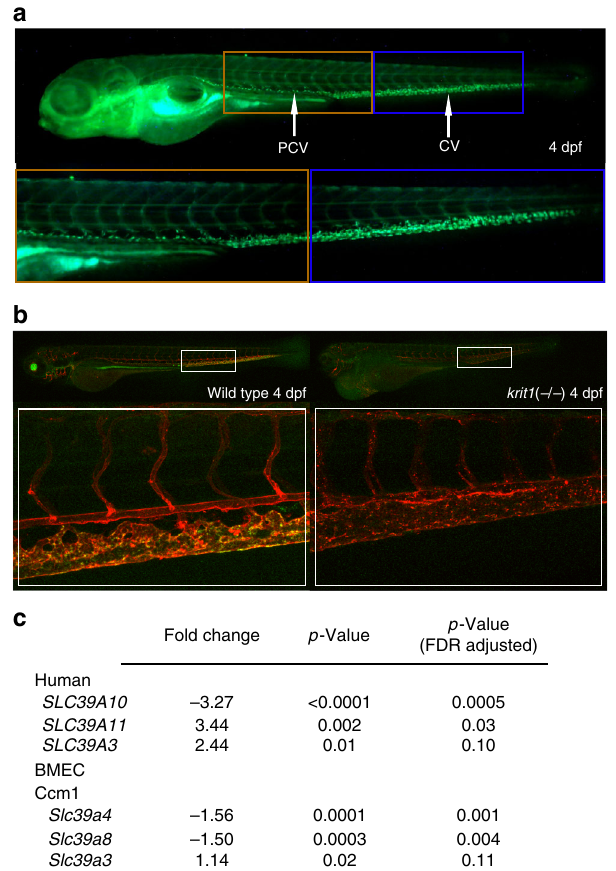
Fig. 6 Zinc localization and SLC39 zinc transporter expression in CCM models. a Zinypr-1 detects zinc in the posterior cardinal vein (PCV) and caudal vein (CV) vasculature of wild type zebra fi sh 4 days post fertilization (dpf). b Zinc localization in the PCV and CV is lost in the absence of krit1/ ccm1 4dpf. The endothelial cell vasculature is marked in red, and zinc appears green (yellow overlay). c SLC39 zinc transporter expression in CCM lesion tissue from patients (human) and in brain microvasculature endothelial tissue (BMEC) of endothelial-speci fi c knockout mice (BMEC Ccm1) from isolated brain microvascular endothelial cells (BMEC) with wild-type mice. In Krit1/Ccm1 mouse mutant BMECs there was a signi fi cant downregulation of Slc39a4 and Slc39a8 transcripts (Fig. 6c), and a slight upregulation of Slc39a3 . To determine if the